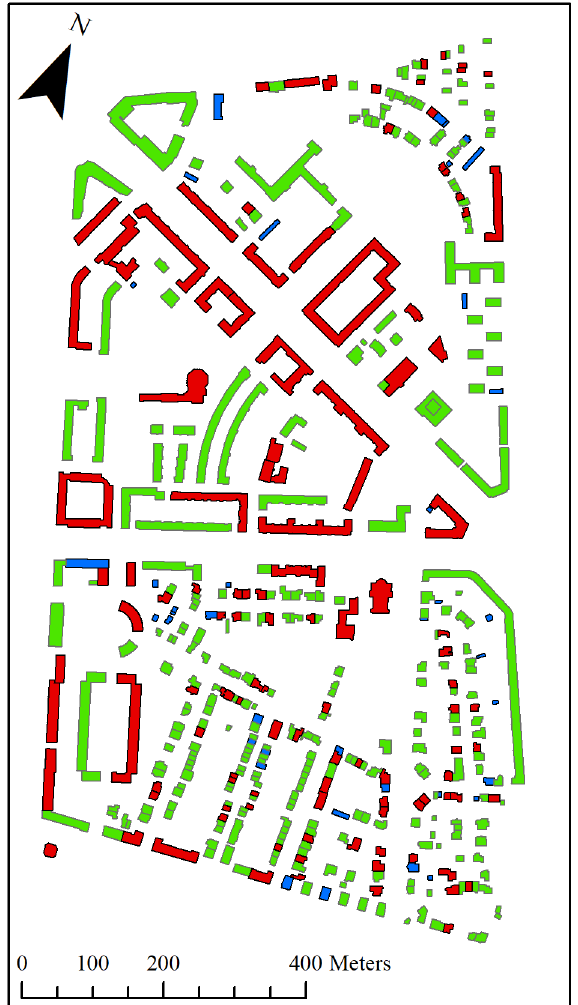
Table 4. The results of the qualitative assessment and the